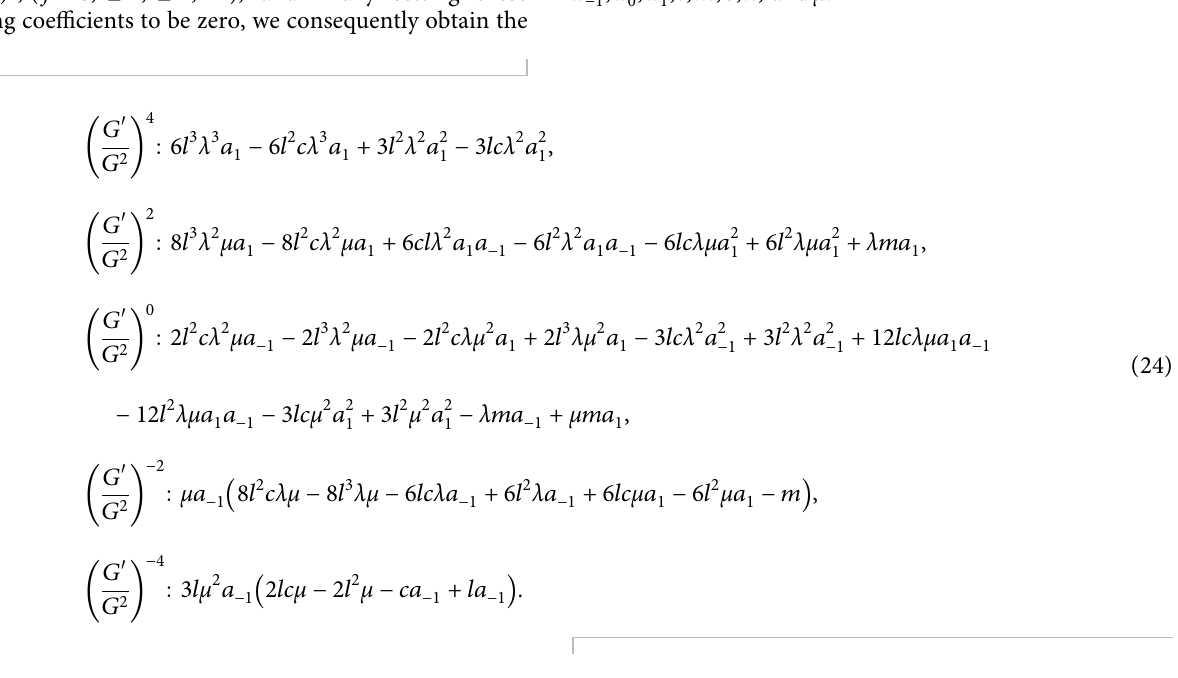
Figure 2: Breather wave (17) for equation (1) with ϵ the real part of the wave. (b) The overhead view of the wave. (c) The wave propagation pattern of the wave along the x axis with y �